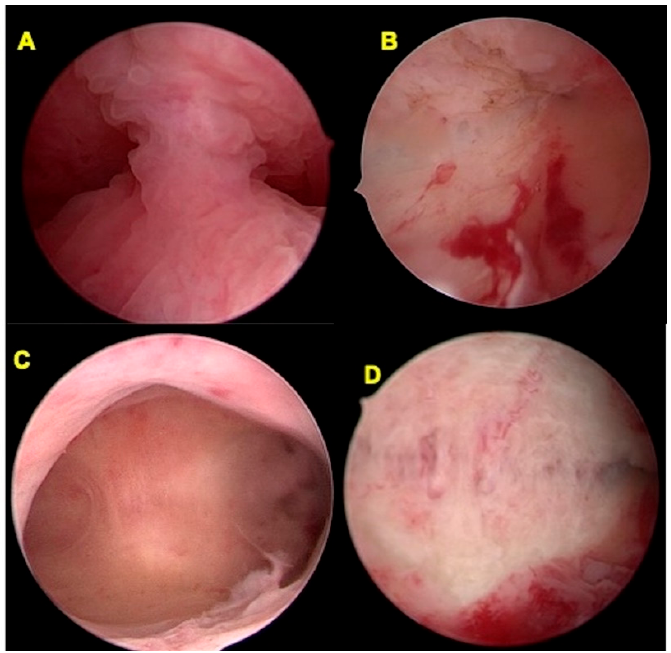
Figure 1. Hysteroscopic view of a complete and partial uterine septum before and after hysteroscopic metroplasty. ( A ) Hysteroscopic view of a complete uterine septum at the beginning of surgery; ( B ) Hysteroscopic view of the previous uterine cavity at the end of the metroplasty; ( C ) Hysteroscopic view of a partial complete uterine septum at the beginning of surgery; ( D ) Hysteroscopic view of the previous uterine cavity at the end of the metroplasty.